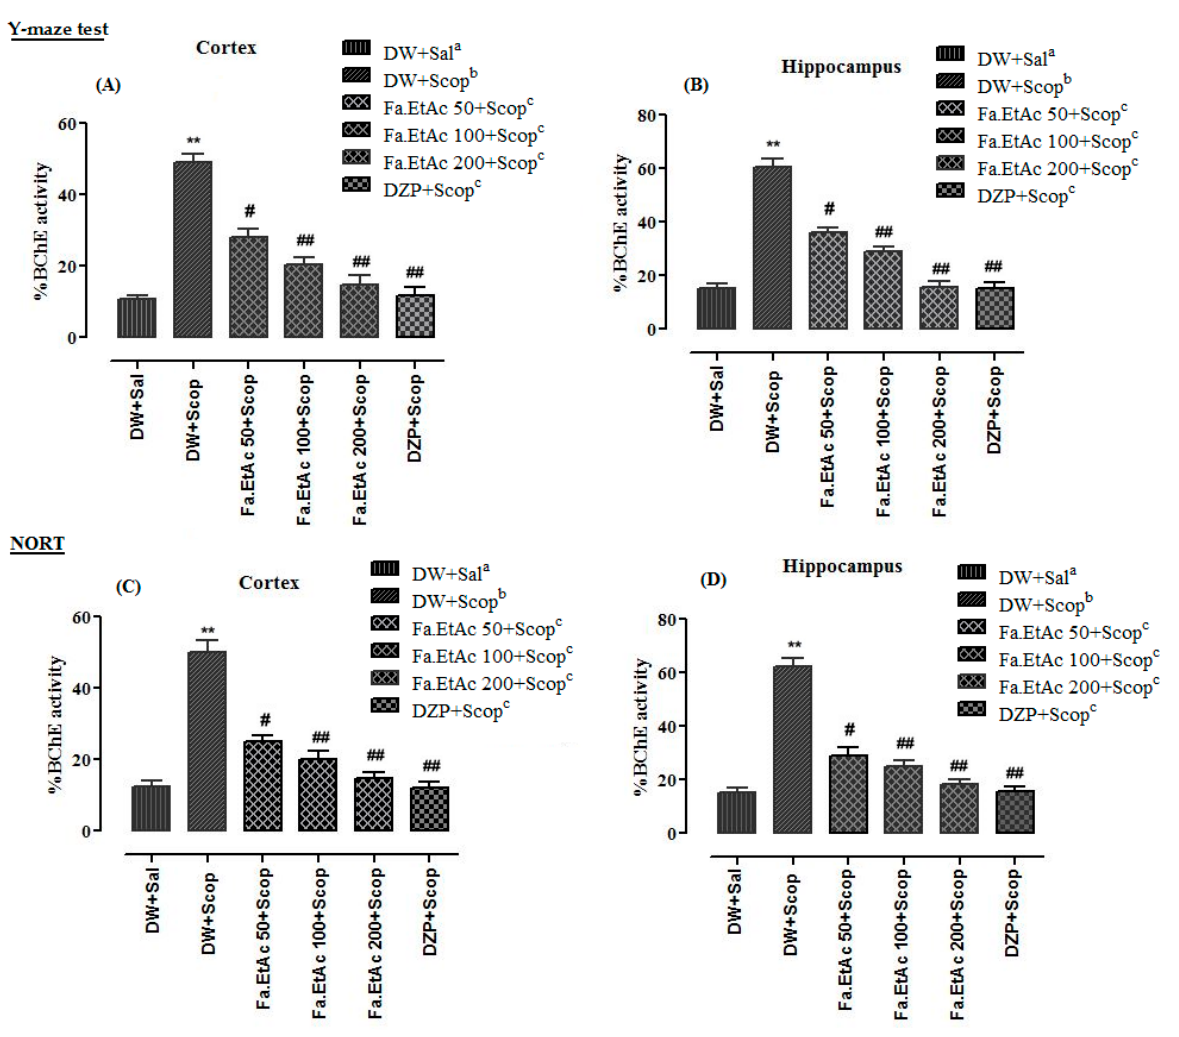
Figure 7. Ex vivo % BChE activity in the ( A ) frontal cortex and ( B ) hippocampus of different animal in Y-maze behavioural task and ( C , D ) NORT. The data are expressed as Mean ± SEM; each value corresponds to a mean of eight animals. One-way ANOVA followed by Dunnett’s post hoc multiple comparison test to determine the values of p . ** p < 0.01; comparison of DW + Sal a (Normal control) vs. DW + Scop b (Scopolamine treated), # p < 0.05 and ## p < 0.01; comparison of (DW + Scop) b vs. DZP + Scop c (Donepezil treated) and Fa.EtAc c (50, 100 and 200 mg/kg)-treated groups), ns: values not significantly different in comparison to (DW + Scop) b -treated group using one-way ANOVA followed by Dunnett’s post hoc multiple comparison test.